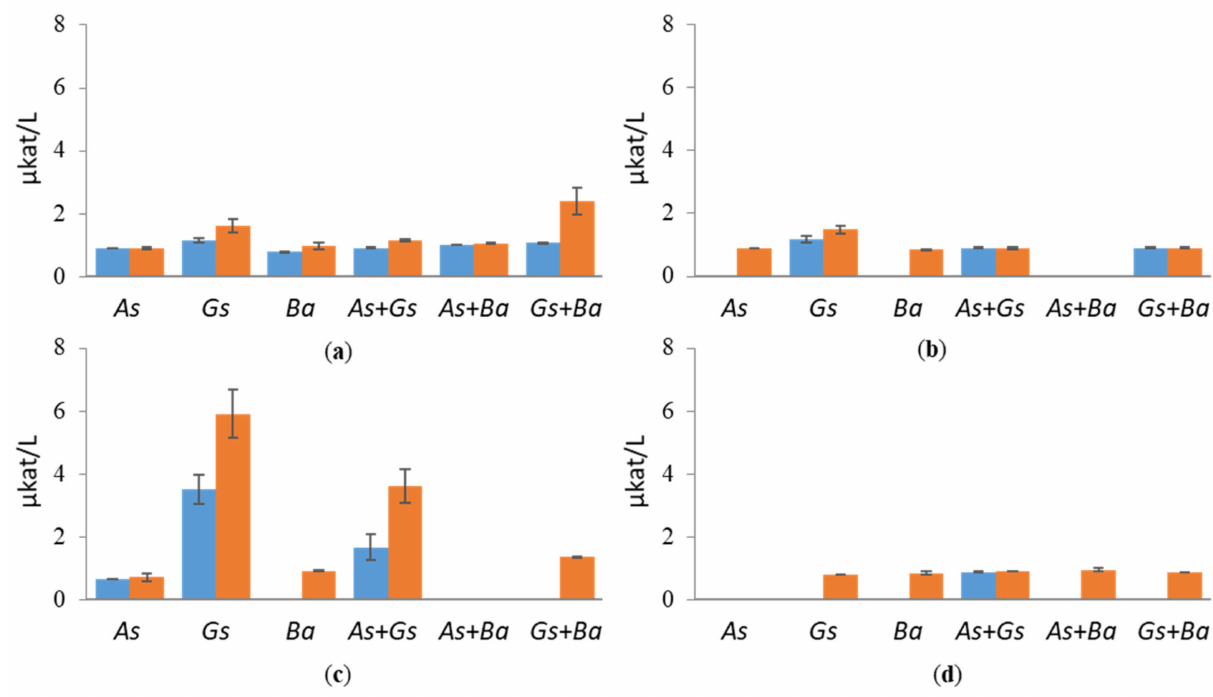
Figure 4. Endoxylanase (XLN) activities at early (day 10, marked in blue) and late time points (day 24, marked in red) in single and co-cultivation on ( a ) birch, ( b ) spruce, ( c ) pine wood and ( d ) Avicel. As = A. sinuosa , Gs = G. sepiarium , Ba = B. adusta , As + Gs = A. sinuosa and G. sepiarium , As + Ba = A. sinuosa and B. adusta , Gs+Ba = G. sepiarium and B. adusta . Error bars refer to standard deviation (SD) ( n = 3). * indicates statistical difference among single and co-cultivations ( p <